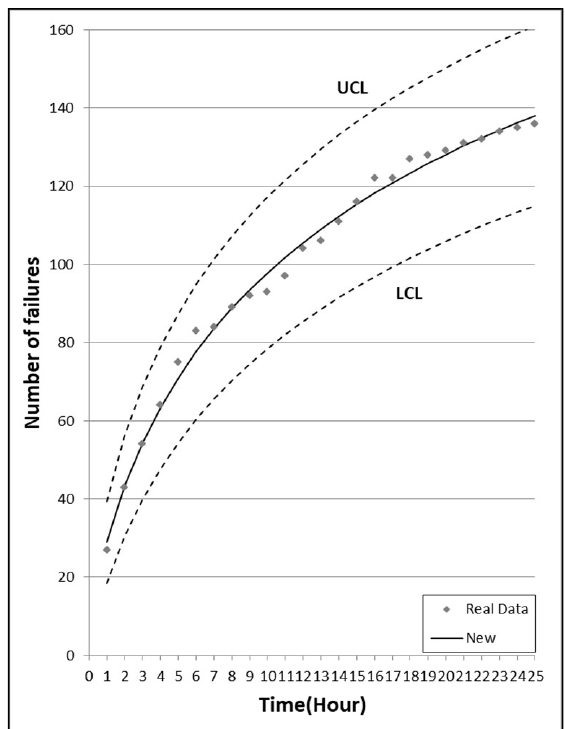
Figure 5. 95% confidence limits of the newly proposed model for DS1.